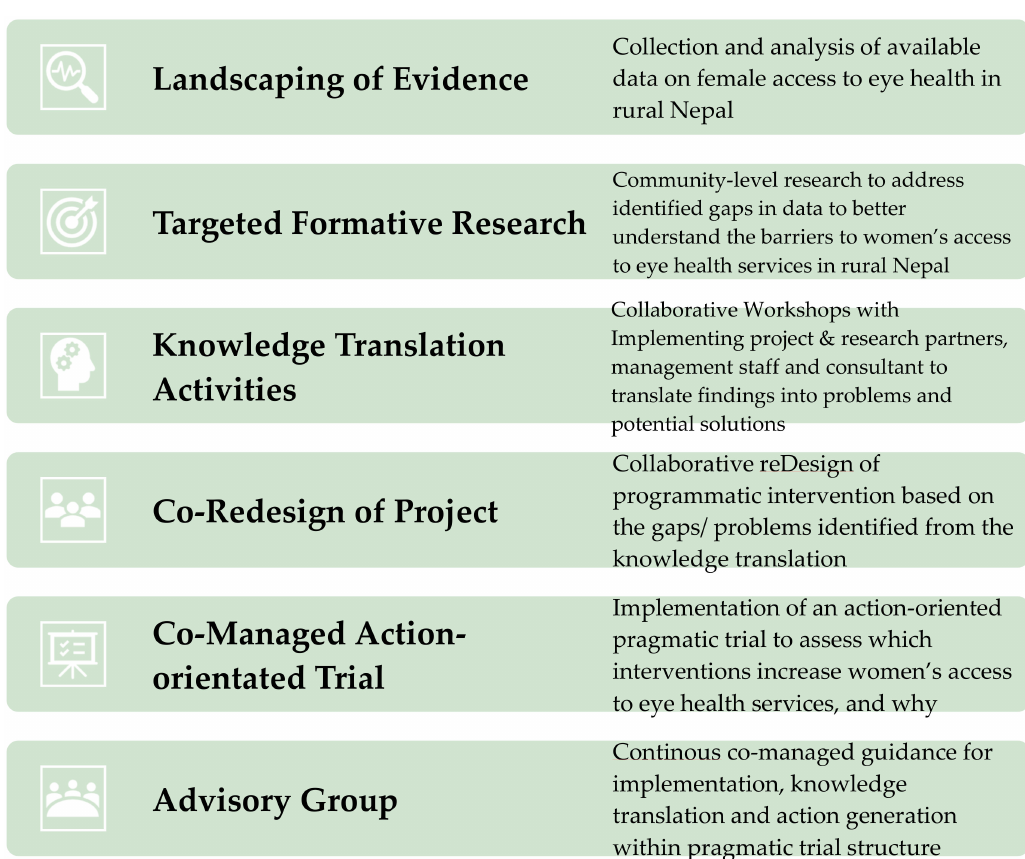
Figure 1. Continuous knowledge translation